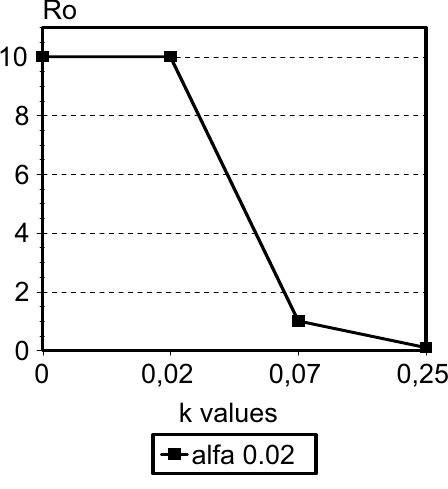
Fig. 2 –Variation of R o according to κ values. R o is the number that defines the onset of the epidemic. The interruption of the infection cycle and of the epidemics would occur at R o ≤ 1 (Dye 1996). We analyzed the variation of R o ( y axis) in relation to κ values ( x